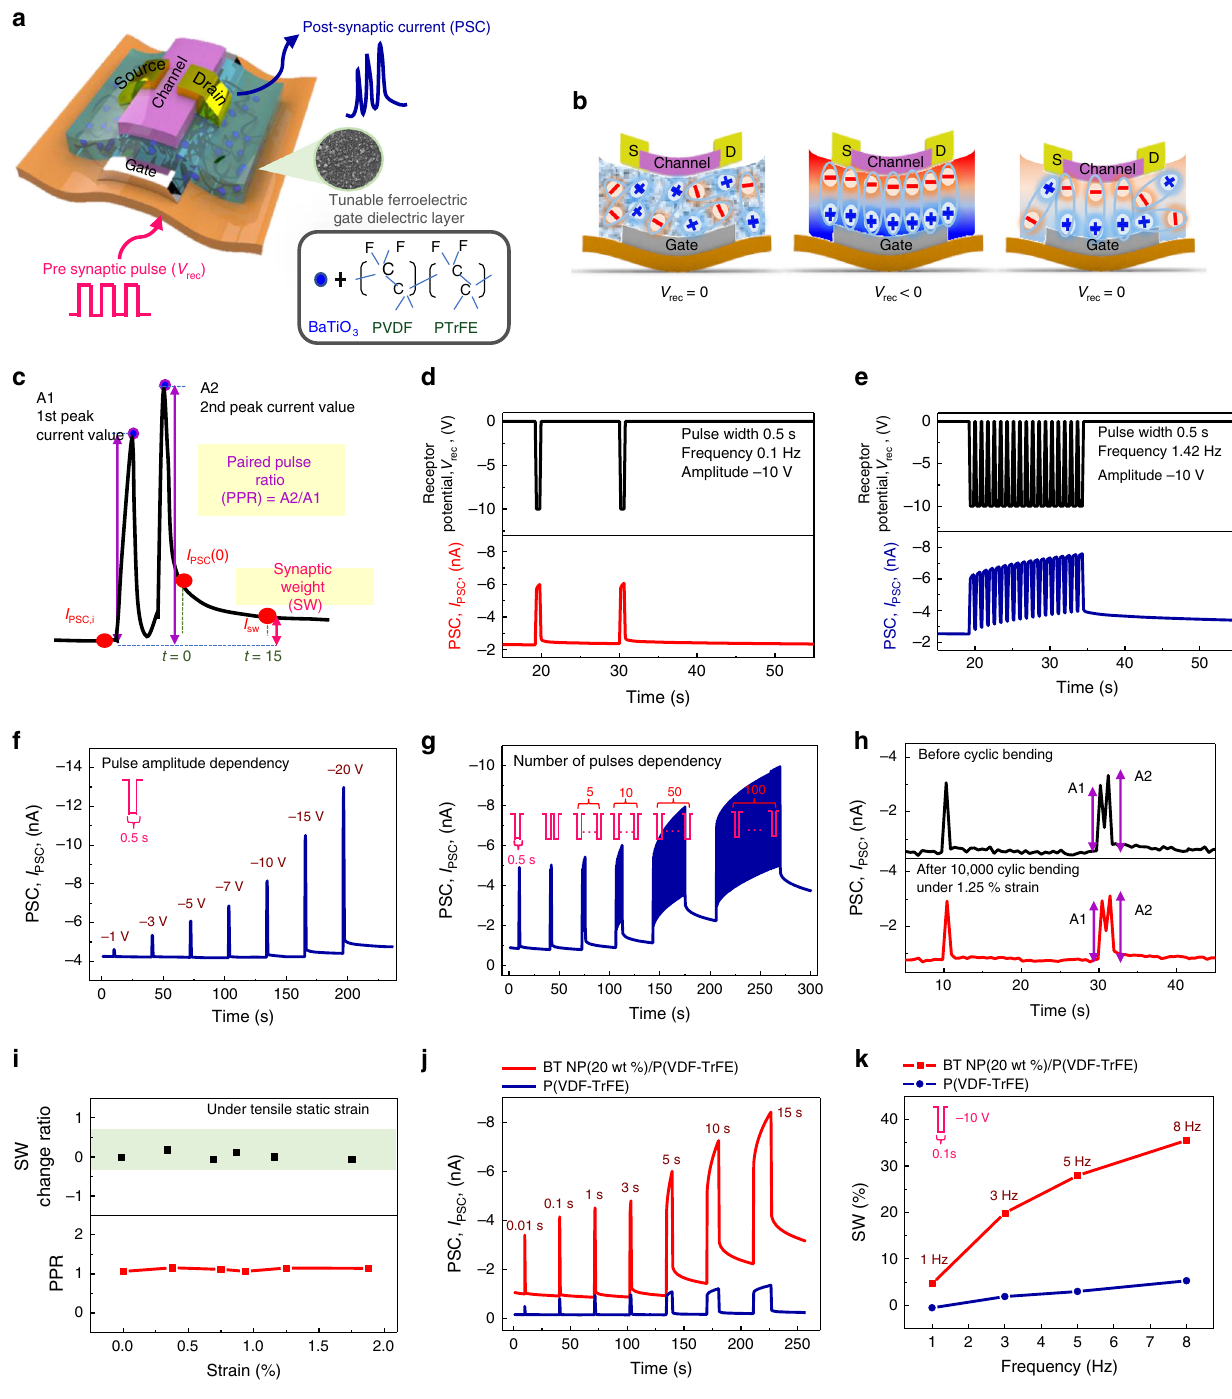
Fig. 2 Analysis of synaptic properties of Fe-OFET. a Sketch of device structure. Pre-synaptic pulse corresponds to an electrical gate bias voltage, V rec . Gate dielectric layer consists of BT NPs/P(VDF-TrFE) ferroelectric material. b Mechanism by which the post-synaptic current (PSC) is generated. Schematic explaining the alignment of ferroelectric dipoles before applying V rec (left), during application of a negative V rec (middle), and after removal of the V rec (right). c Schematic explanation of synaptic weight (SW) and paired pulse ratio (PPR). d , e Short-term potentiation (frequency of 0.1 Hz, d ) and long-term potentiation (frequency of 1.42 Hz, e ) were triggered by applying − 10 V V rec pulses. PSC dependence on f V rec amplitude (pulse width, 500 ms). g Number of V rec pulses (amplitude of − 10 V and pulse width of 500 ms). h PSC before (black) and after (red) a cyclic bending test. PSC in response to a pulse and successive pulses of − 10 V V rec with a pulse width of 500 ms (pulse interval of successive identical pulses, Δ t rec = 500 ms). i Variations in SW change ratio and PPR under different static tensile strain. PSC of devices with BT NP(20 wt%)/P(VDF-TrFE) (red) and P(VDF-TrFE) only (blue) ( j ), as a function of V rec pulse duration. (amplitude of V rec , − 10 V) ( k ), at different frequencies of V rec (amplitude of − 10